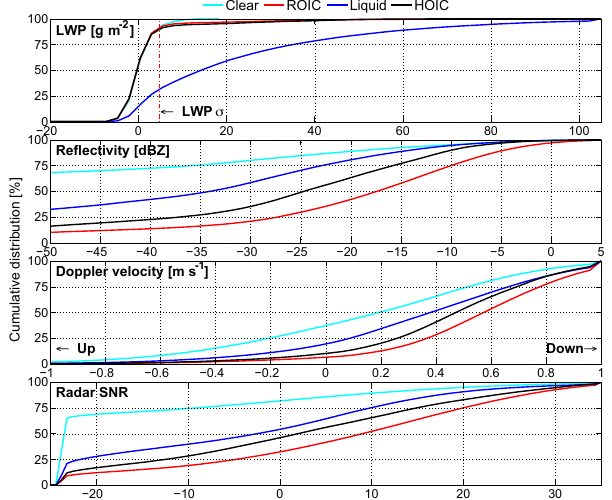
Figure 6. Cumulative distribution functions of co-located ICE- CAPS data parsed by CAPABL classification type. All data from July 2016 to December 2016, approximately 54million radar vox- els for each Doppler moment and 148000 MWR column measure- ments, are collected and identified. Note that the average LWP un- certainty is given for the entire study period and that here a positive mean Doppler velocity is defined towards the zenith-pointing radar system or downwards. For the LWP uncertainty, assuming an effec- tive radius of r e = 10µm, a density of water of ρ = 1000kgm − 3 , and using the approximate relation LWP = 2 τr e ρ/ 3 (Bendix, 2002) yields a threshold for optical depth of τ = 0 .